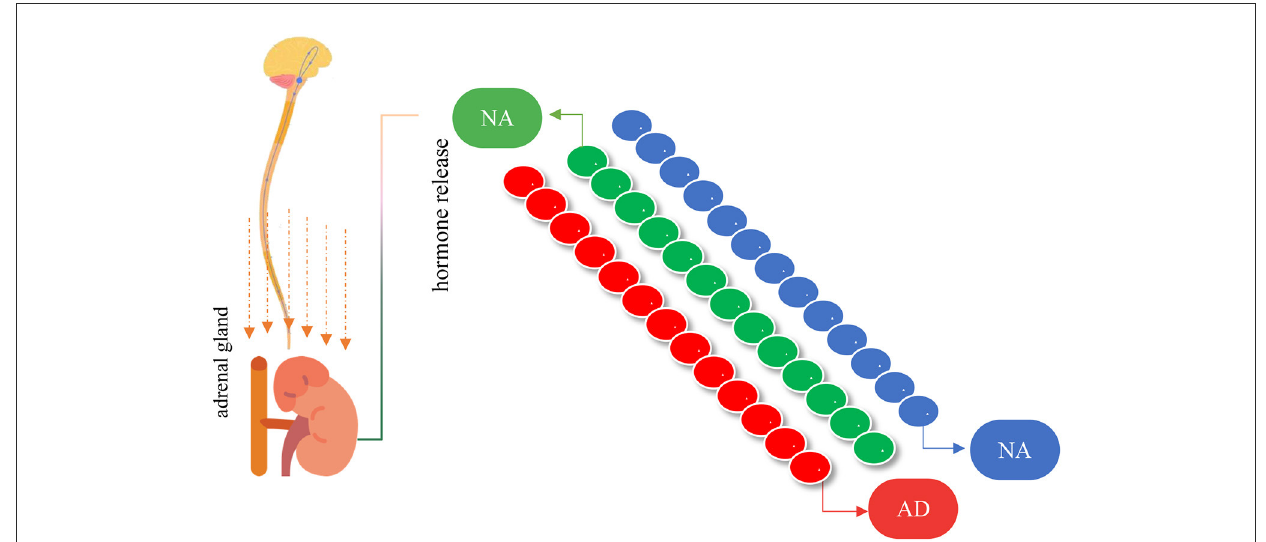
FIGURE8 Illustration of the initial response when there is a stressor stimulus in cattle. The sympathetic nervous system stimulates the adrenal gland to release catecholamines [adrenaline (AD) and noradrenaline (NAD)] and cortisol